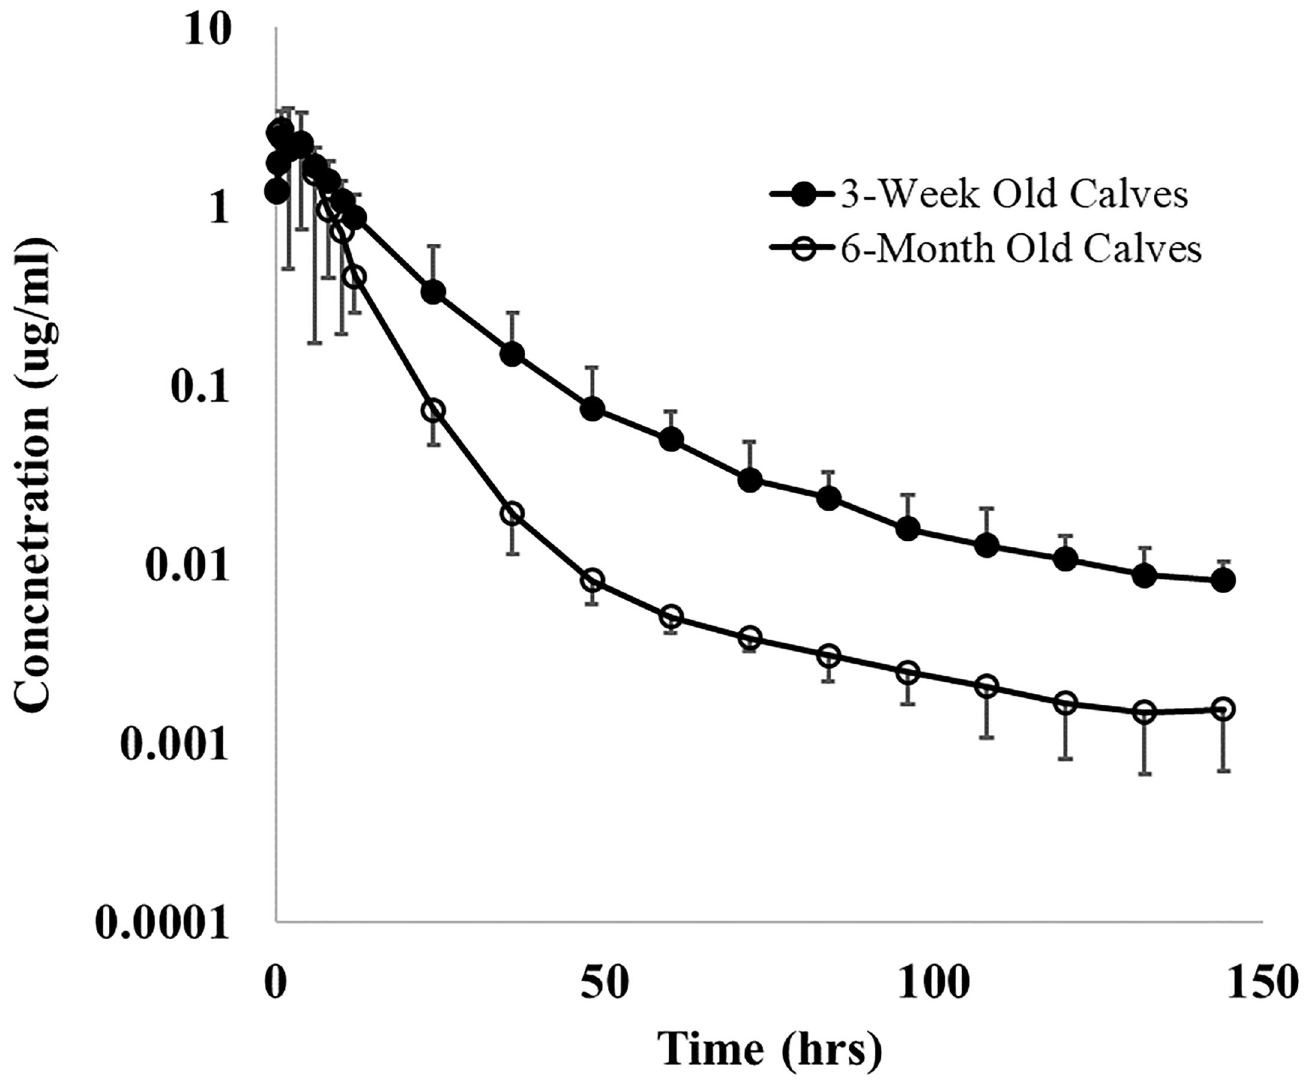
Fig 1. Mean ( ± SD) plasma concentrations of danofloxacin. Danofloxacin was administered by subcutaneous route at doses of 8 mg/kg in 3-week and 6-month old calves with induced respiratory disease from P . Multocida .